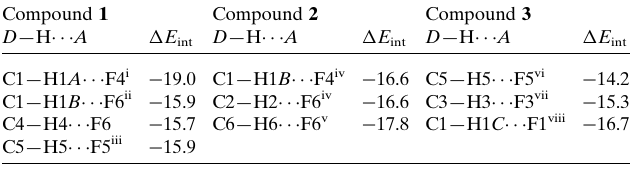
Table 4 Cation–anion interaction energies (kcal mol (cid:3) 1 ). Compound 1 Compound 2